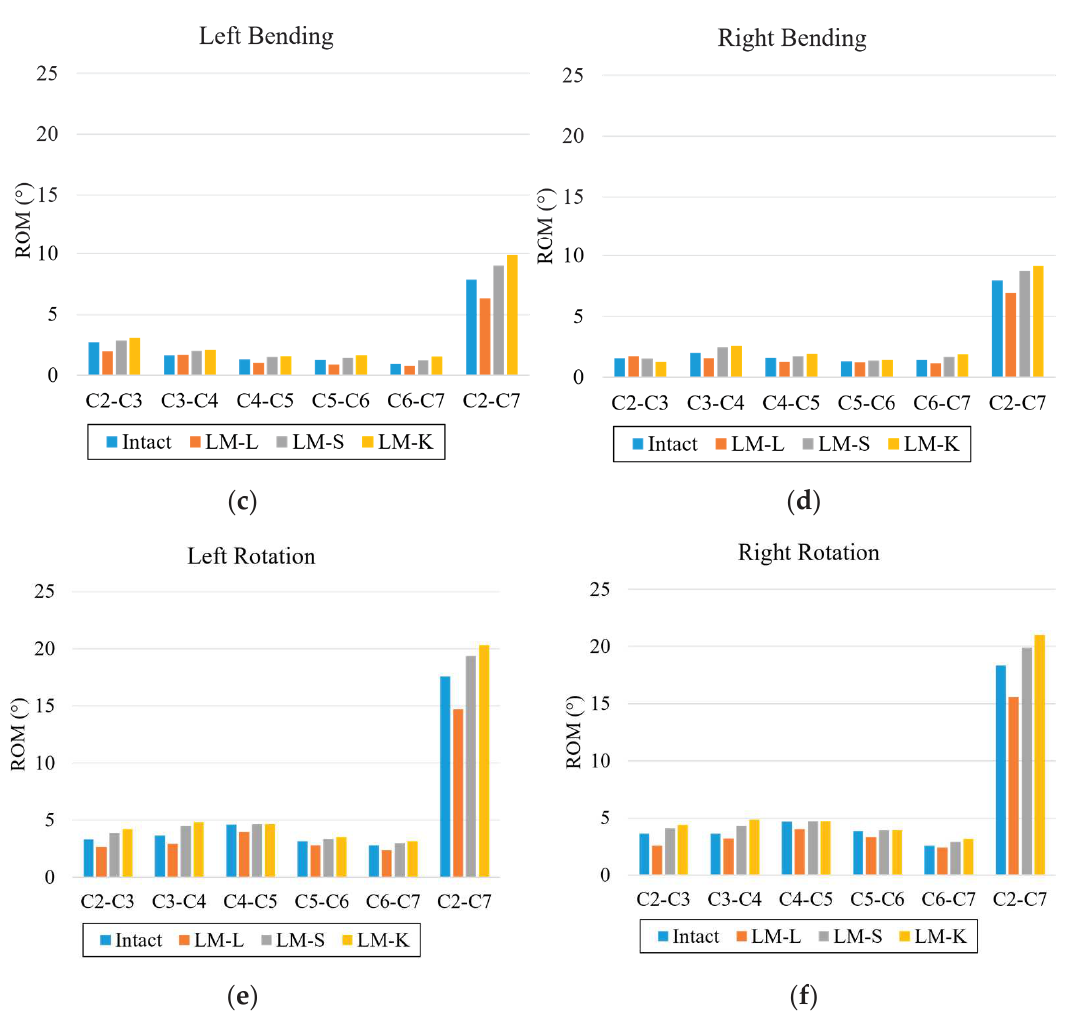
Figure 2. Range of motion: ( a ) extension, ( b ) flexion, ( c ) left bending, ( d ) right bending, ( e ) left rotation, and ( f ) right rotation. The vertical axis is the angle (degree); the horizontal axis is each intervertebral level.